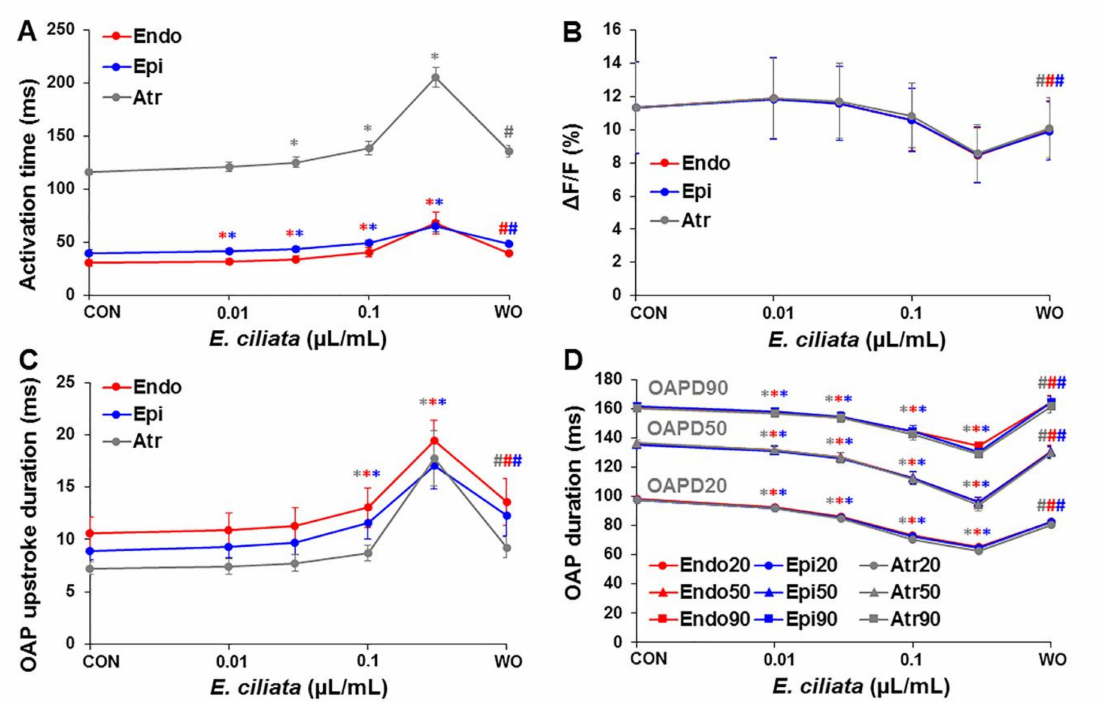
Figure 6. Dependence of the OAP on the E. ciliata concentrations. Steady-state level measurements during atrial / endo- / epi-cardial stimulation (300 ms period) of ( A ) activation time, ( B ) voltage-sensitive fraction of fluorescence ( ∆ F / F), ( C ) OAP upstroke duration (UD), and ( D ) OAP duration (OAPD) at 20%, 50% and 90% of repolarization, done under the control (CON) conditions and at the end of each 10 min perfusion with 0.01, 0.03, and 0.1 µ L / mL concentrations of the E. ciliata (except for 0.3 µ L / mL the perfusion was ~5 min), followed by a washout (WO) period (* p < 0.05 for E. ciliata vs. control; # p < 0.05 for washout vs. E. ciliata of 0.3 µ L / mL concentration; n = 6 for